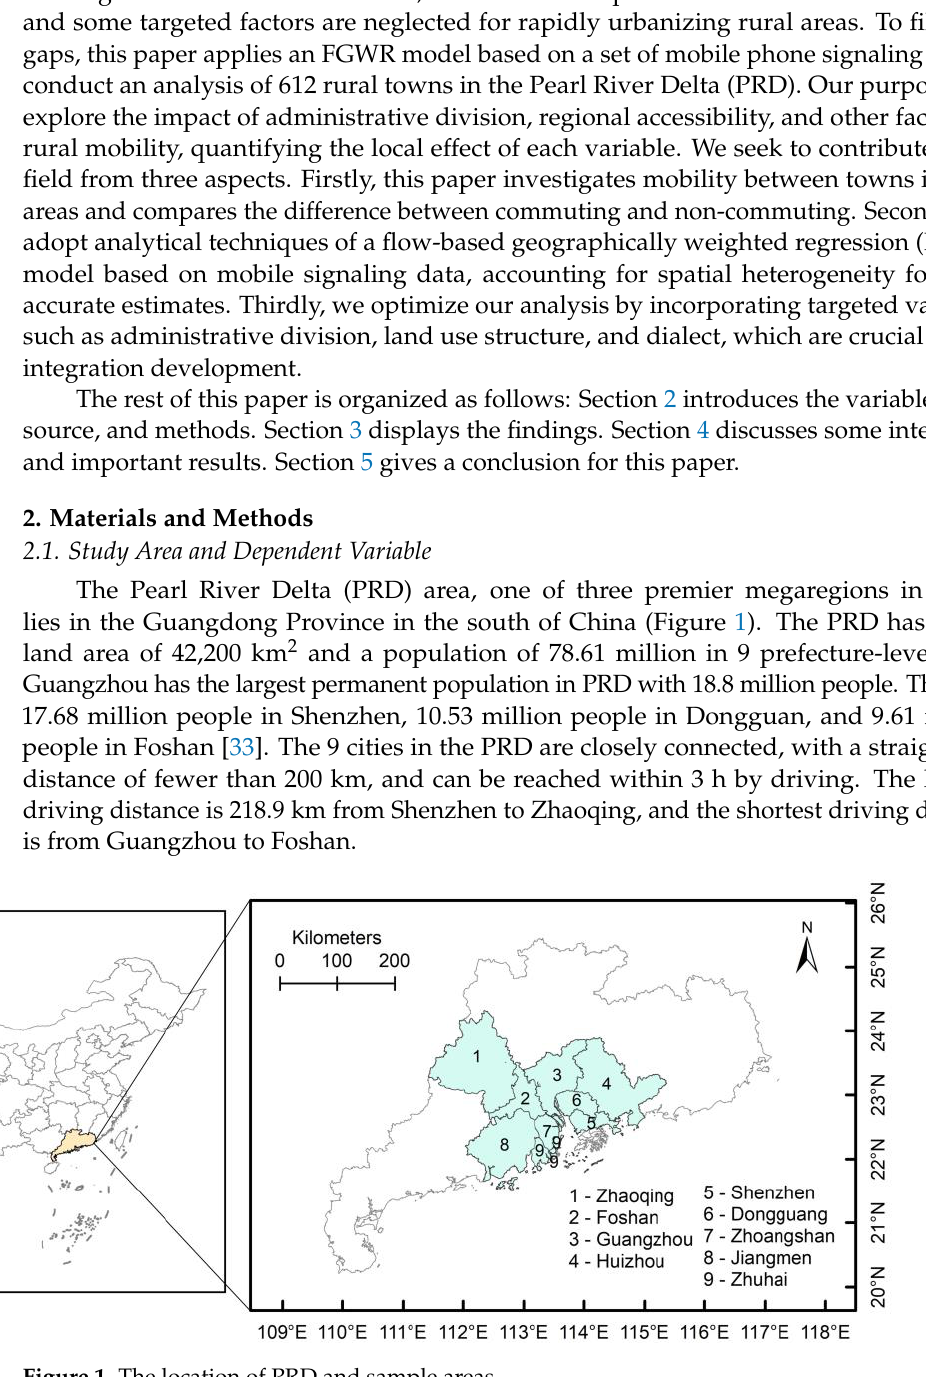
Figure 1. The location of PRD and sample areas.